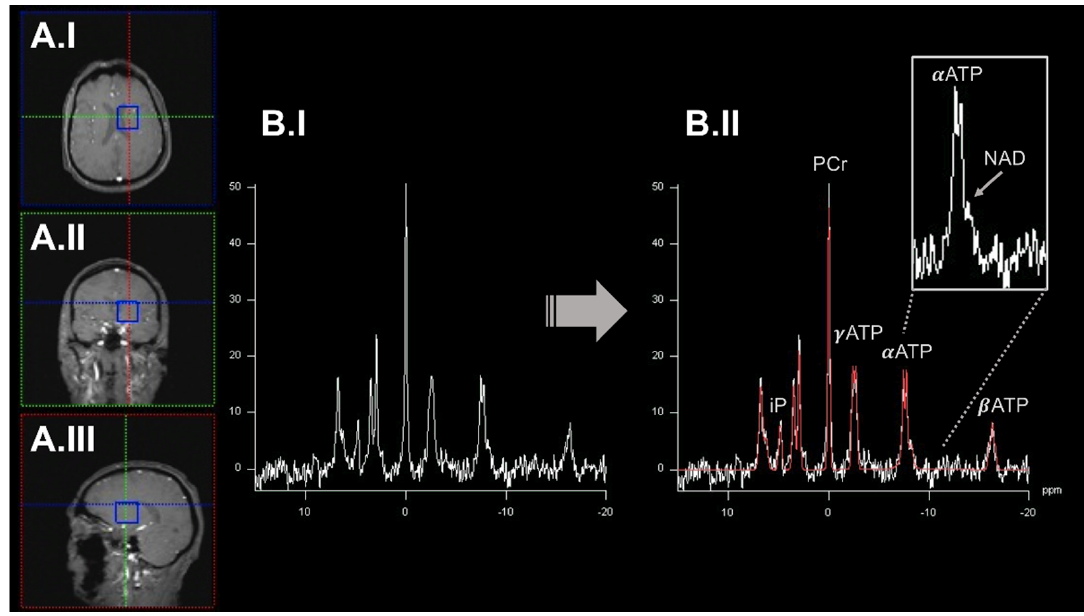
Figure 3. An exemplary illustration of 31 P-MRSI acquisition workflow. Here, we highlighted an ac- quired spectrum from a single voxel (blue box) displayed in axial (panel A.I), coronal (panel A.II), and sagittal (panel A.III). The preprocessed (before peak-annotation) spectrum is shown in panel B.I. In panel B.II, the different peaks of the spectrum have been annotated based on a model fit (highlighted in red) by incorporating prior knowledge. Metabolite levels can be quantified by calculating the respective area under the peak. ATP gives rise to three signal peaks ( α / β / γ ATP) based on the number of phosphorus nuclei in this molecule. Some metabolite peaks overlap (e.g., α ATP and NAD; right upper corner). Here, elaborate experimental setups, acquisition protocols, and higher static magnetic field strengths are desirable to disentangle these metabolites. 31 P-MRSI: 31 phosphorus magnetic resonance spectroscopy imaging. ATP: adenosine triphosphate. iP: inorganic phosphate. NAD: nicotinamide adenine dinucleotide. PCr: phosphocreatinine. ppm: parts per million.